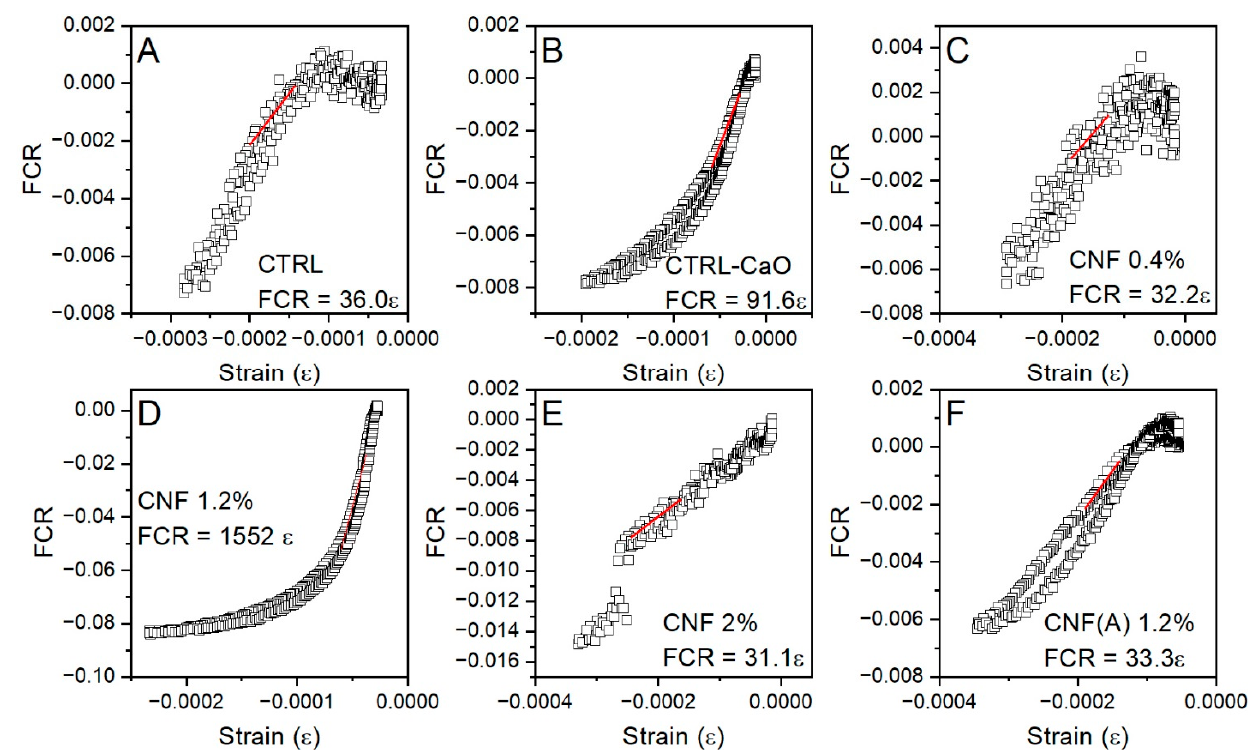
Figure 10. FCR versus strain for mortar specimens at different CNF concentrations under a monotonic uniaxial compressive loading with an amplitude of 7.5 MPa. ( A ) Control mortar; ( B ) control mortar with CaO substrate; ( C ) mortar with 0.4 wt% of CNF; ( D ) mortar with 1.2 wt% CNF; ( E ) mortar with 2.0 wt%; ( F ) mortar with 1.2 wt% washed CNF.